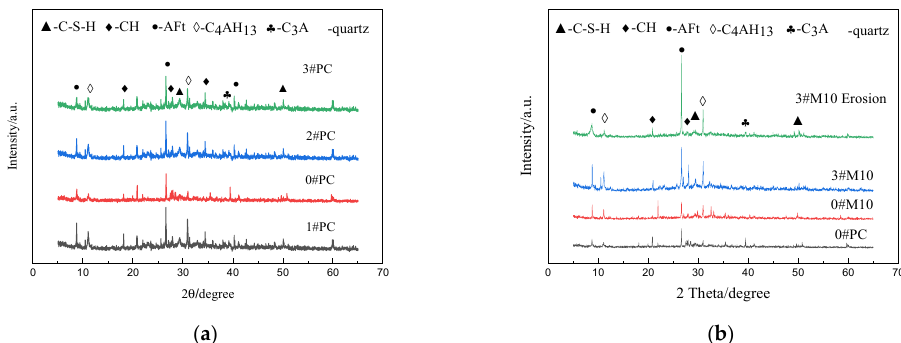
Figure 9. XRD patterns of PC and M10 after curing 28 days under various curing methods; ( a ) PC (0#,1#,2#,3#), ( b ) PC (0#) and M10 (0#, 3#).